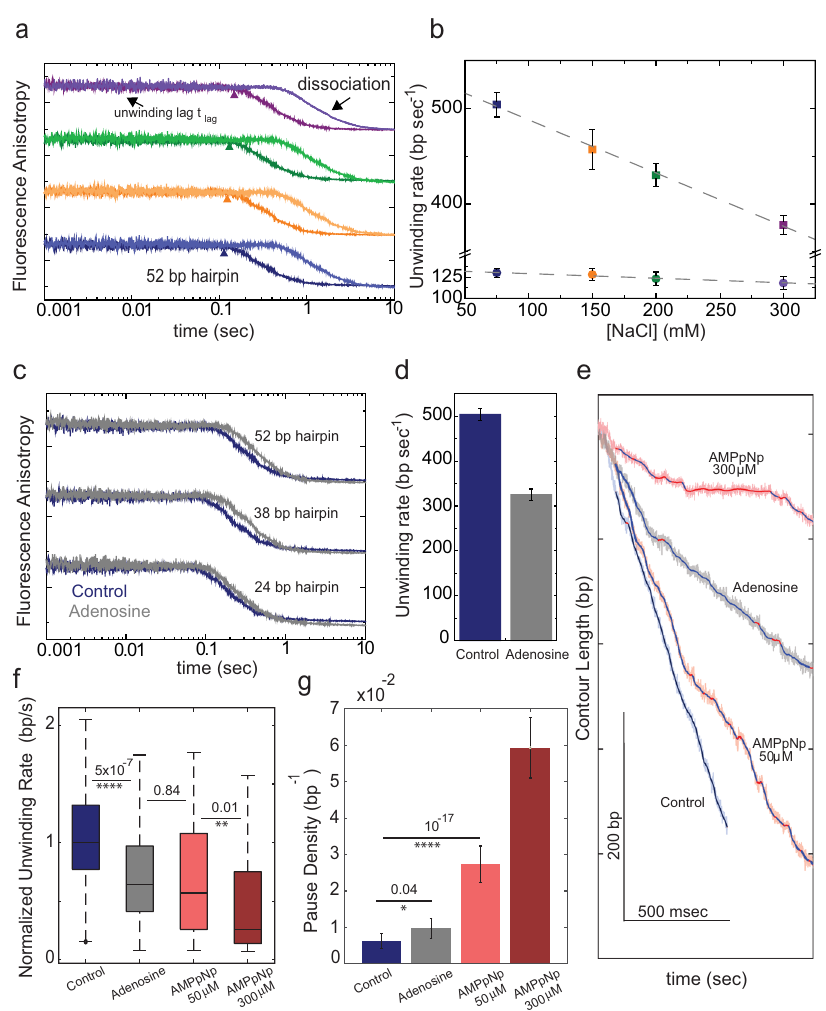
Fig. 4 Rapid mixing, fl uorescence anisotropy measurements of real-time unwinding by RecBCD. a FA time courses of unwinding reactions of RecBCD·hpDNA (52 bp; 250nM, post-mixed) with ATP (350 μ M, strong colors and 100 μ M, light colors). Time courses were vertically shifted for clarity. Difference colors indicate time traces at 75 mM (blue), 150 mM (orange), 200 mM (green), and 300 mM (purple) NaCl concentrations. The curves are averages of ten traces. b Unwinding rates as a function of [NaCl], as calculated from the slopes in the lag-time vs. construct length curve (Supplementary Fig. 7C), for high (squares) and low (circles) [ATP]. Error bars indicate the standard error, as calculated from the fi t. c FA time courses of unwinding reactions for a RecBCD·hpDNA complex (250 nM, post-mixed; top: 52 bp, middle: 38 bp, bottom: 24 bp) at [ATP] = 350 μ M and [NaCl] = 75 mM, in the absence (blue) and the presence (gray) of 2 mM adenosine. Time courses were vertically shifted for clarity. The curves are averages of 10 (blue) and 15 (gray) traces. d Unwinding rate in the absence and the presence of 2 mM adenosine, calculated from the slope of lag-time vs. construct length curves. Error bars indicate the standard error, as calculated from the fi t. e Representative traces of single-molecule unwinding/translocation experiments in the presence of adenosine (gray) and AMPpNp (light red, 50 μ M and dark red, 300 μ M), at 2 mM ATP. Also shown is a control (blue) in the absence of both adenosine and AMPpNp. Detected pauses are marked in red for all traces. f RecBCD ’ s normalized translocation rates in the absence and presence of adenosine or AMPpNp. Box-and-whiskers plot (median, IQR and min-max). n = 48, 127, 52, and 85 segments lasting 250 msec each, from 22, 46, 20, and 14 traces, for control, adenosine, 50 μ M AMPpNp, and 300 μ M AMPpNp, respectively. The numbers indicate p -values calculated with a two sample Student ’ s t -test, two-sided. **** p < 0.0001, ** p < 0.01. Color coding as in a . g Pause density in the absence and the presence of adenosine and AMPpNp, calculated by dividing the total number of pauses in all traces ( tp ) by the total number of translocated base pairs ( tc ), using 22, 46, 20, and 14 different traces for control, adenosine, 50 μ M AMPpNp and 300 μ M AMPpNp, respectively. The error bars show 95% Poisson con fi dence intervals, i.e., ±1.96 ∙√ ( tp ⁄ tc ). The numbers indicate p -values calculated with a two-sided Chi-squared test, **** p < 0.0001, * p < 0.05.